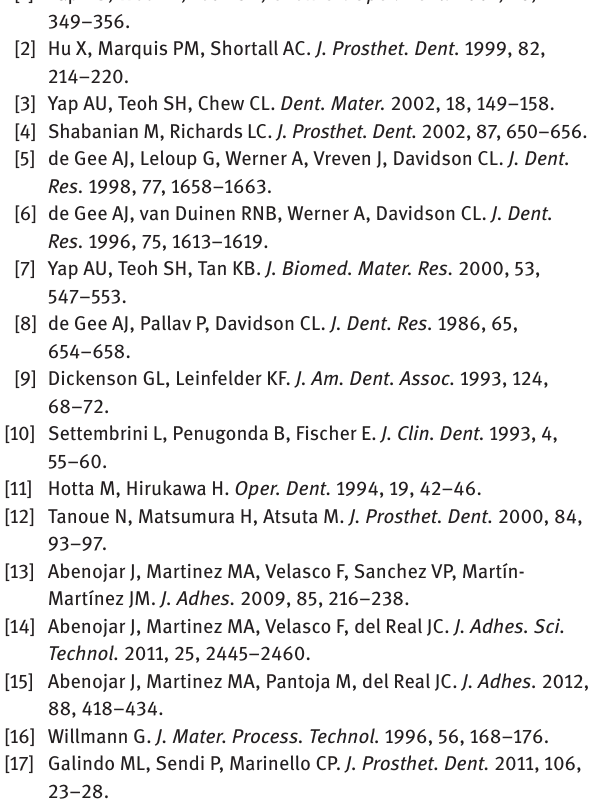
Figure 13H and I indicates the effect of varying filler contents on the volumetric wear of dental composites. Figure 13H indicates a micro­graph of an unfilled dental composite (DC­0), whereas Figure 13I indicates a micro­ graph of 10­wt. % marble dust­filled dental composites (DCMD­10). As per Figure 13H, the unfilled composites indicated more wear compared to the 10­wt. %